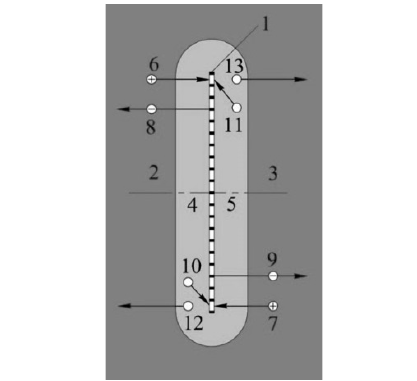
generation using a flat grid immersed in plasma under negative